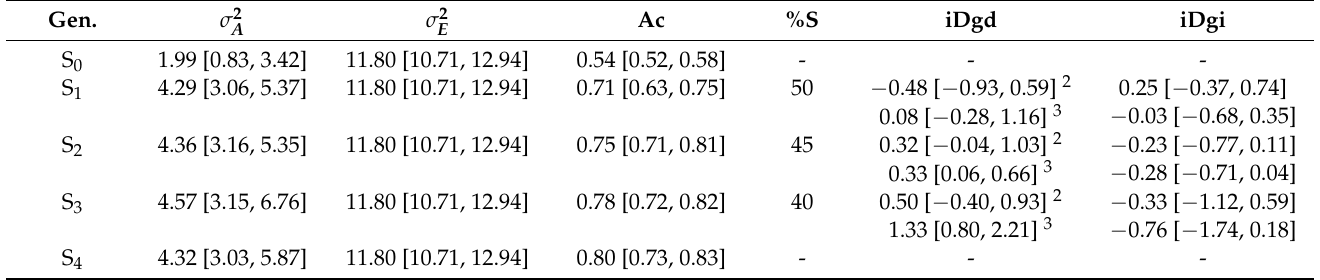
Table 3. Average additive and error variances per generation for EV, percent of selected plants (%S), accuracy 1 , and increments in the direct (mL/g) and indirect genetic gains (g/0.18 m 2 ) with pedigree-based BLUP based on EV, relative to phenotypic mass selection, in the in silico temperate population (minimum and maximum values between